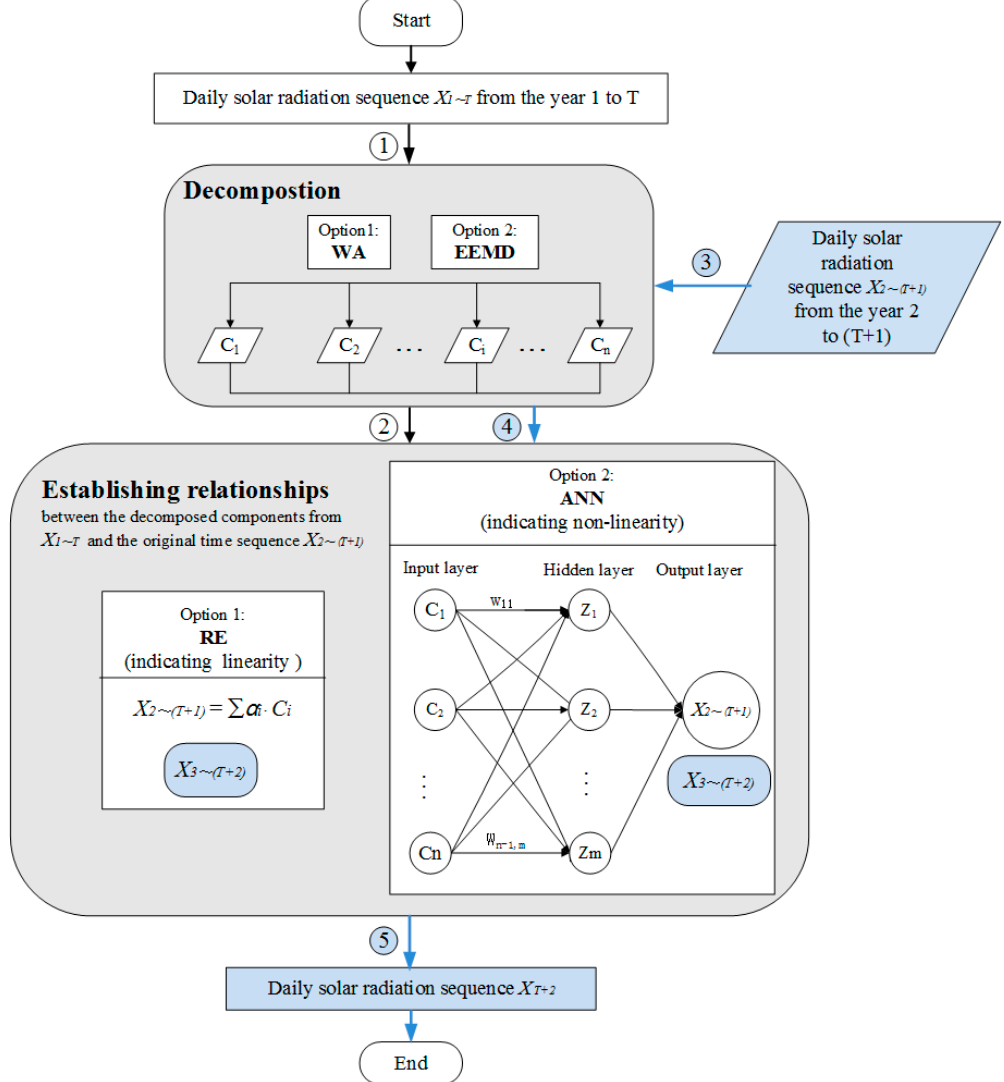
Figure 1. Flowchart of hybrid EEMD-RE, WA-RE, EEMD-ANN, and WA-ANN models.